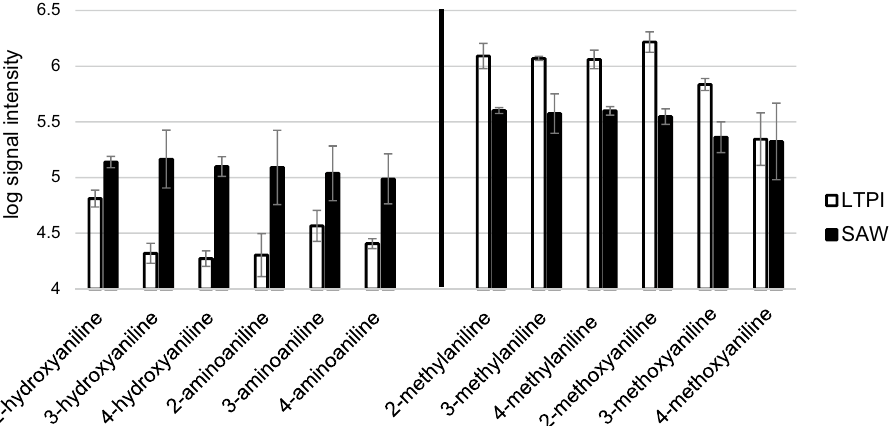
Figure 2. Analytes with a free amino (phenylenediamines) or hydroxyl group (aminophenols) as second substituent (left) responded particularly well to SAWN-LTPI (“SAW”) while methyl group-substituted